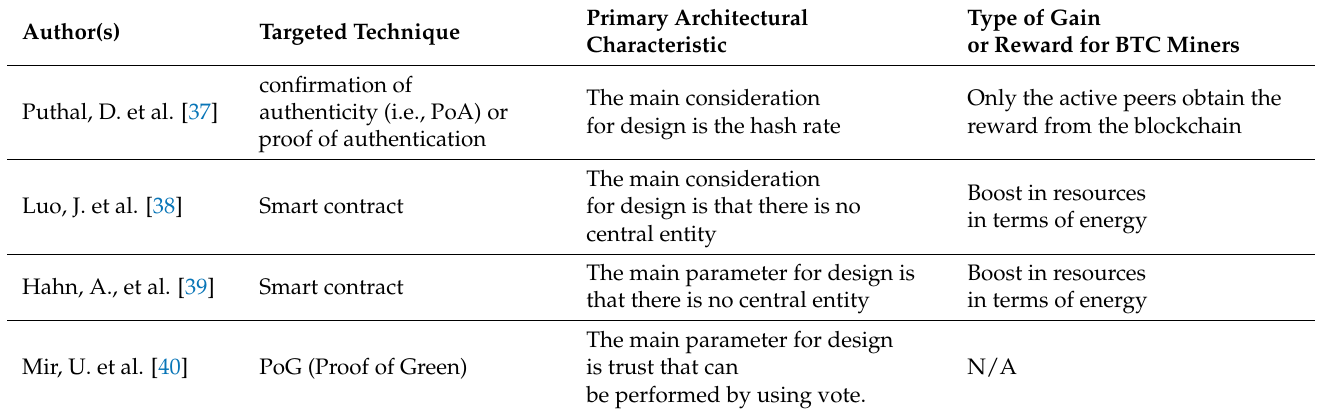
Table 4. Characteristics of currently available energy-efficient approaches suggested for Bitcoin [36].